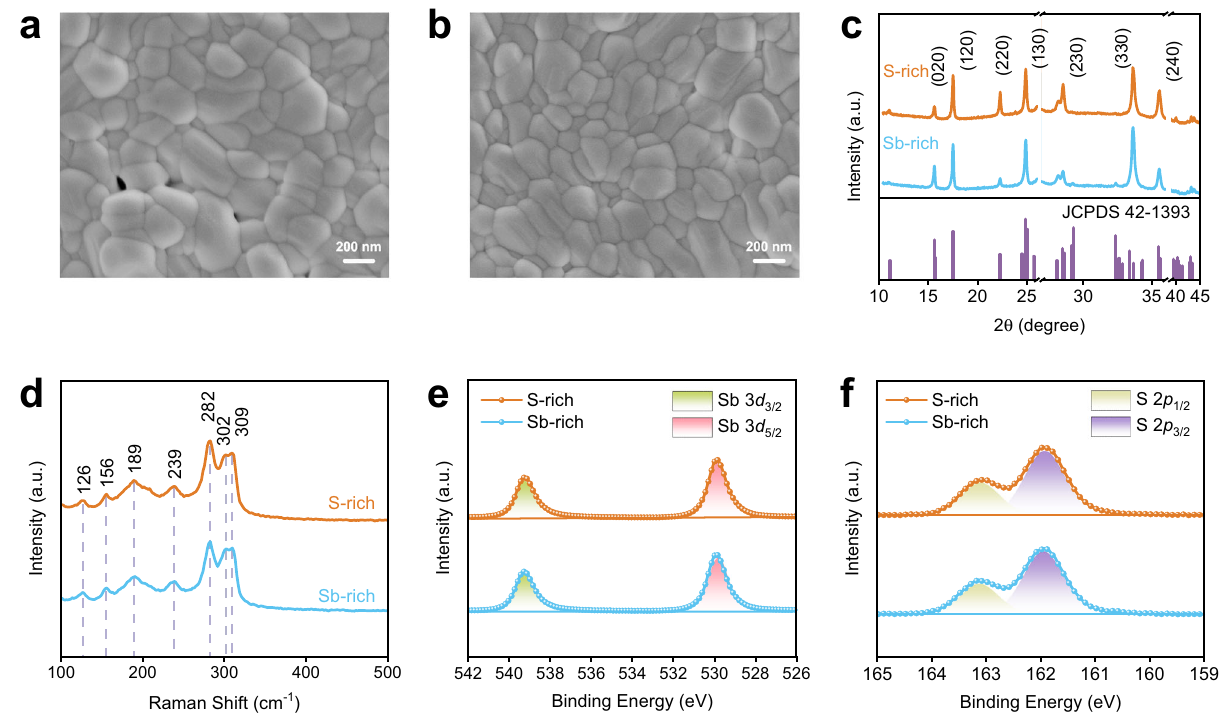
Fig. 2 Characterizations of Sb 2 S 3 fi lms. a , b Surface SEM images of Sb-rich and S-rich Sb 2 S 3 fi lms. c , d XRD patterns and Raman spectroscopy of Sb-rich and S-rich Sb 2 S 3 fi lms. e , f Sb 3 d and S 2 p XPS spectra of Sb-rich and S-rich Sb 2 S 3 .